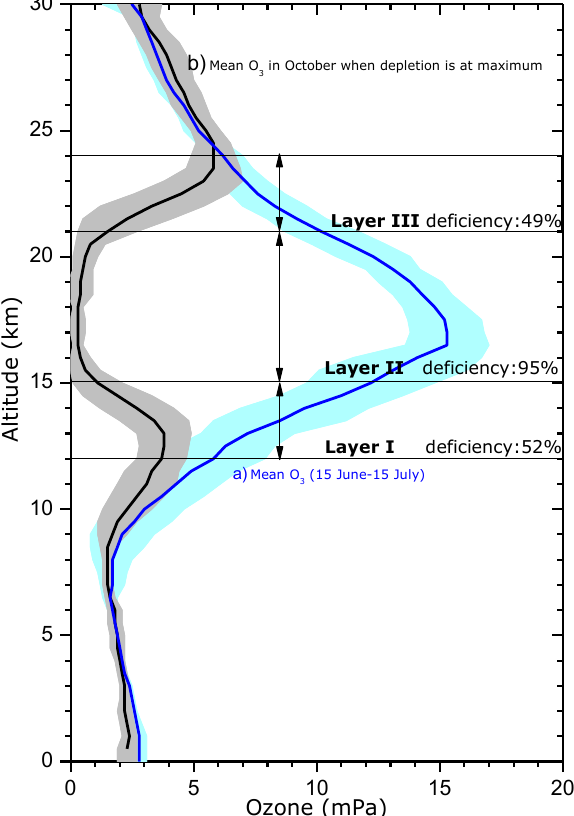
Fig. 1. Mean ozone profiles obtained from the 13yr data (1999– 2011) of Belgrano station. (a) Winter profile typical of pre-ozone- hole conditions for the period 15 June to 15 July (blue line). (b) Figure 1. Mean ozone profiles obtained from 13 years (1999-2011) at Belgrano station. a) 3 October-mean profile, when ozone depletion is at maximum deple- tion (black line). Shaded areas indicate one standard deviation of the Winter profile typical of pre-O hole conditions for the period 15 th June to 15 th July (blue line). 4 3 monthly means within the 13yr average. The three layers of study b) October-mean profile when ozone depletion is at maximum depletion (black line). 5 are Shadowed areas indicate one standard deviation of the monthly means within the 13-year 6 average. The three layers of study are shown. 7